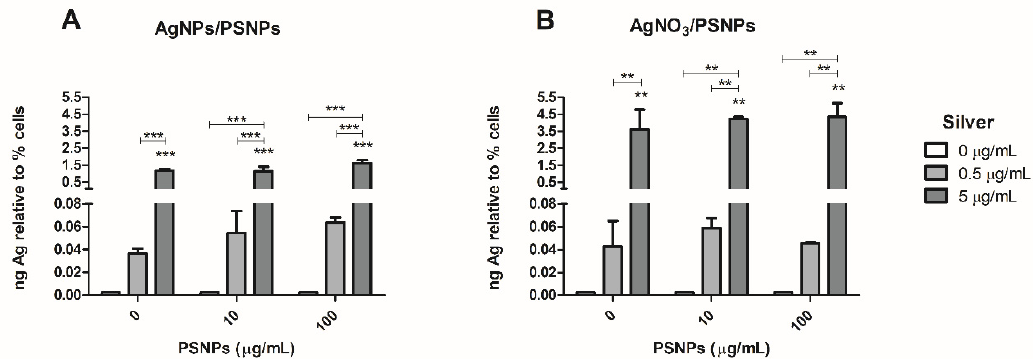
Figure 6. Quantification of the internalized silver by Caco-2 cells after the exposure to 0, 0.5 and 5 µ g/mL/0, 10 and 100 µ g/mL of AgNPs/PSNPs ( A ) or AgNO 3 /PSNPs ( B ). Data were obtained by averaging three independent experiments performed in duplicates. The duplicates of each experiment were averaged, and the percentage of viable cells was used to normalize the results. ICP-MS device did not detect silver in those samples treated without silver, so these results are arbitrarily represented as 0.0025 ng of silver. Data are represented as mean ± SEM and was analysed by one-way ANOVA with Tukey’s multiple comparison post-hoc test, ** p ≤ 0.01, *** p ≤ 0.001.